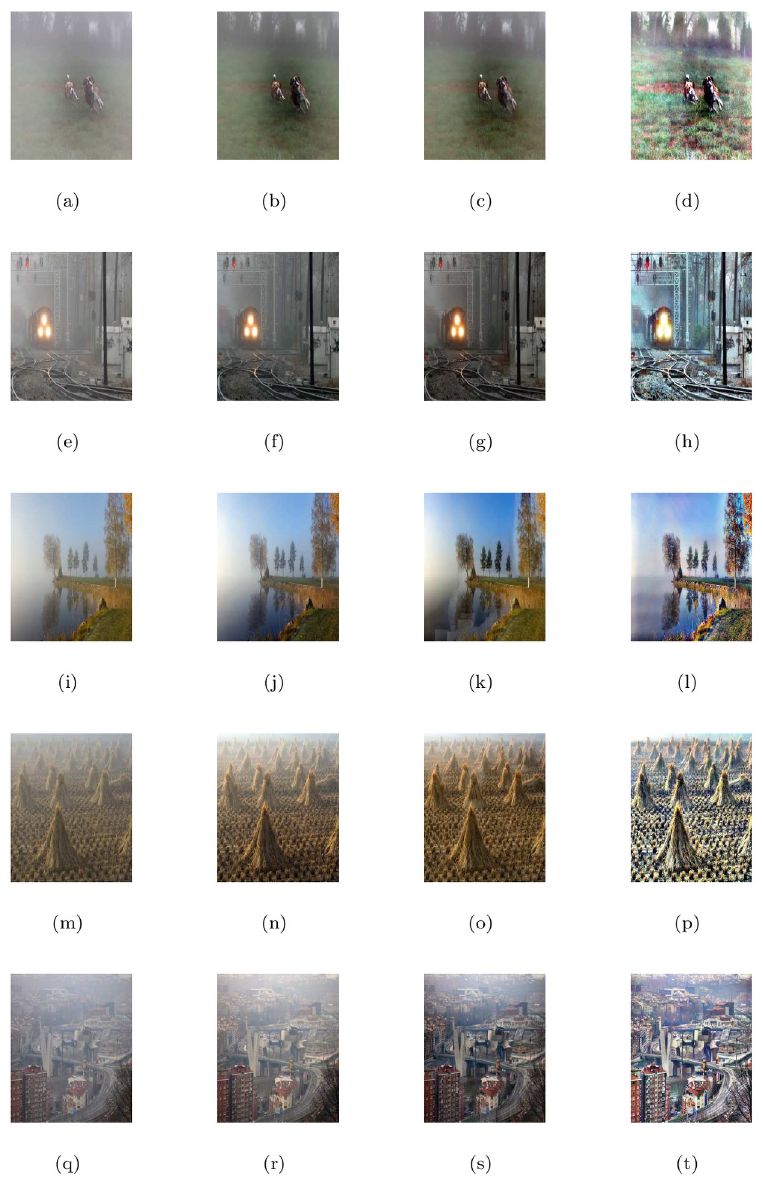
Fig 11. De-hazing performance of the proposed model in comparison with M1 and M2. From L to R columns represent the given images, M1, M2 and proposed model results, respectively.